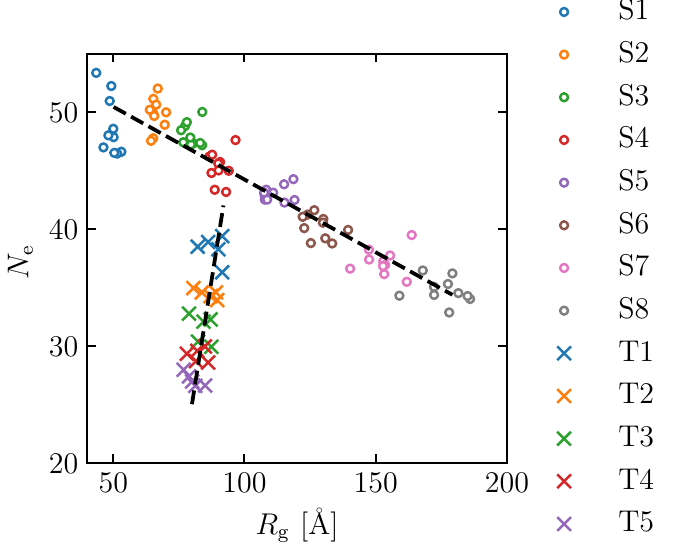
Figure 3. Distribution of radius of gyration ( R g ) and number of entanglement ( N e ) for the molecular structures of S1–S8 ( ) and T1–T5 ( ). ◦ ×